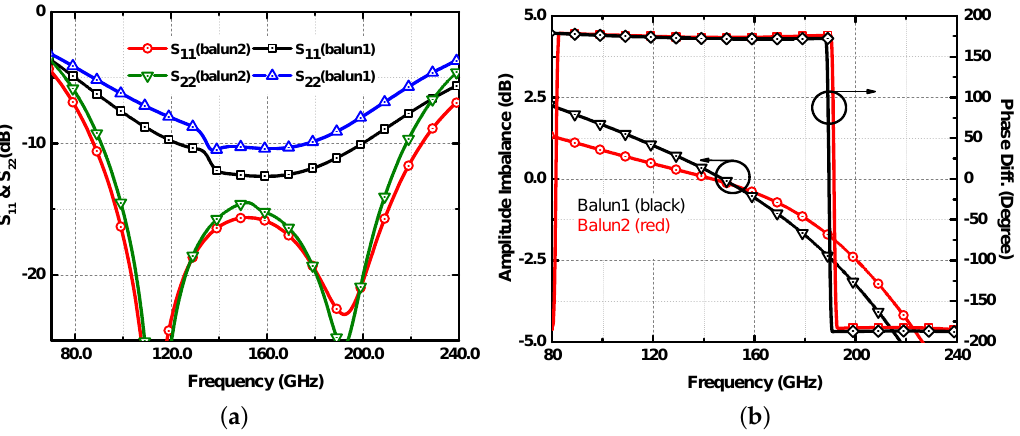
Figure 6. Simulated input/output reflection coefficients ( S 11 , S 22 ) ( a ) and amplitude imbalance and phase difference ( b ) of the two baluns.